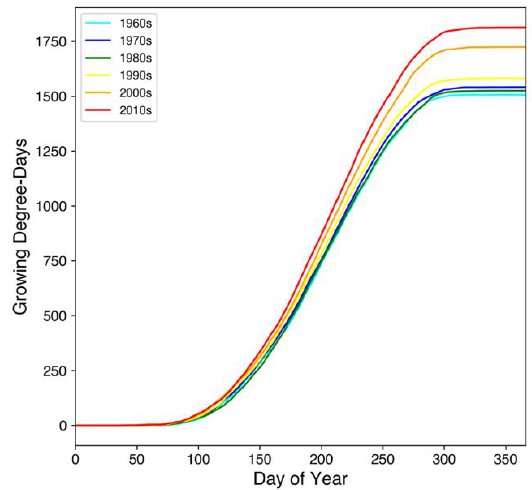
Figure 13. Cumulative growing degree-days by decades.